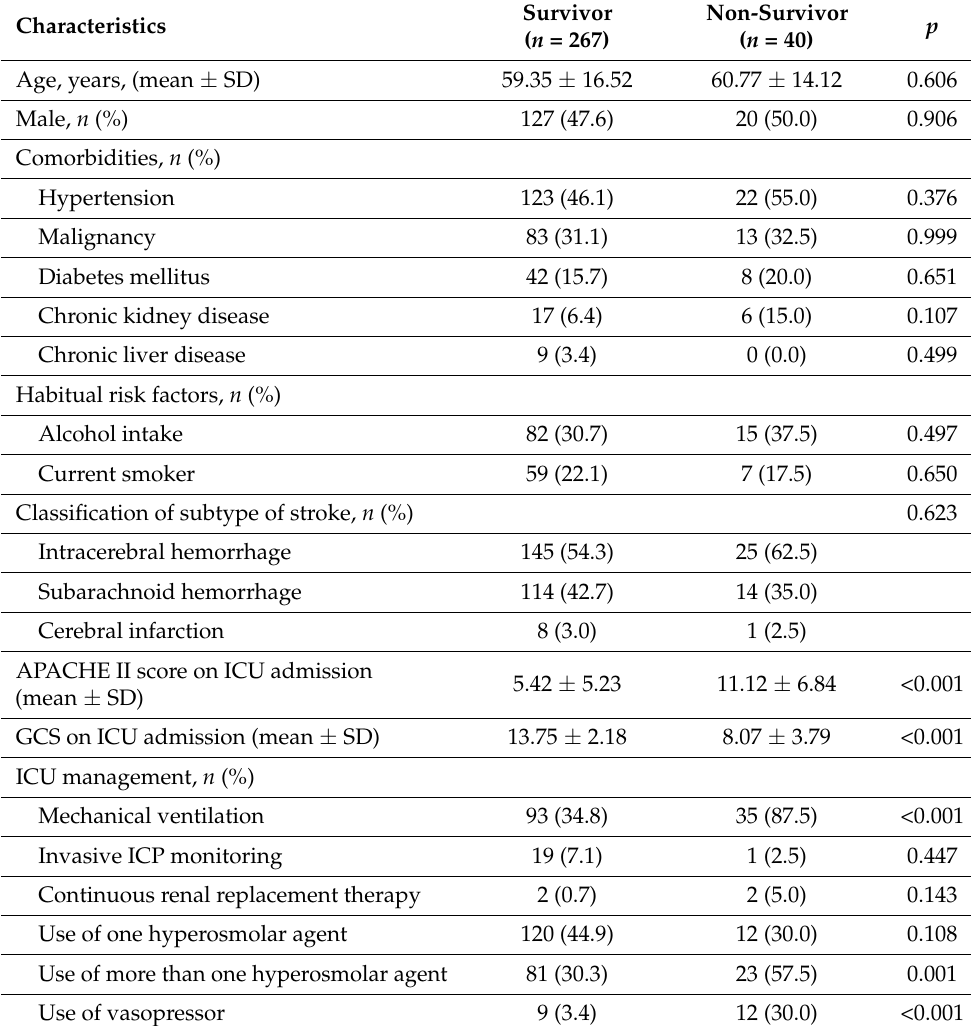
Table 1. Comparison of baseline characteristics between the survivors and non-survivors.